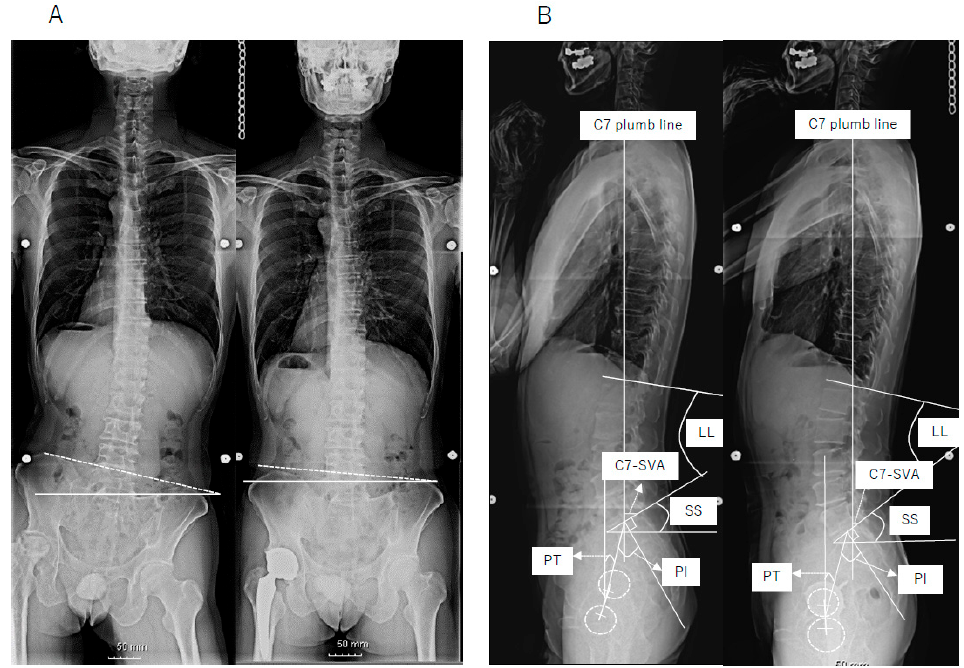
Figure 1. ( A ) Preoperative (left) and postoperative (right) frontal radiographs, showing pelvic obliquity angle, which was defined as the angle between the line connecting the bilateral iliac crests and a horizontal line. ( B ) Preoperative (left) and postoperative (right) lateral radiographs, showing spinopelvic